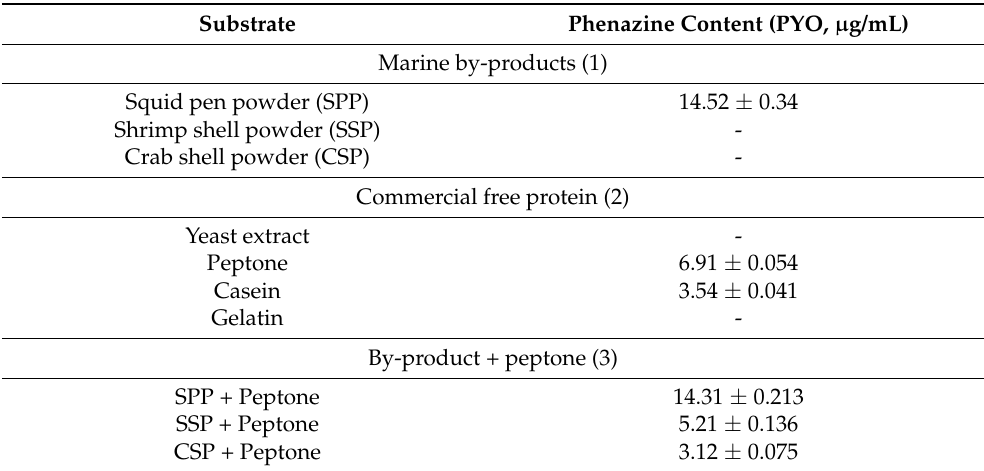
Table 1. Experiments for screening the most suitable phenazine-producing